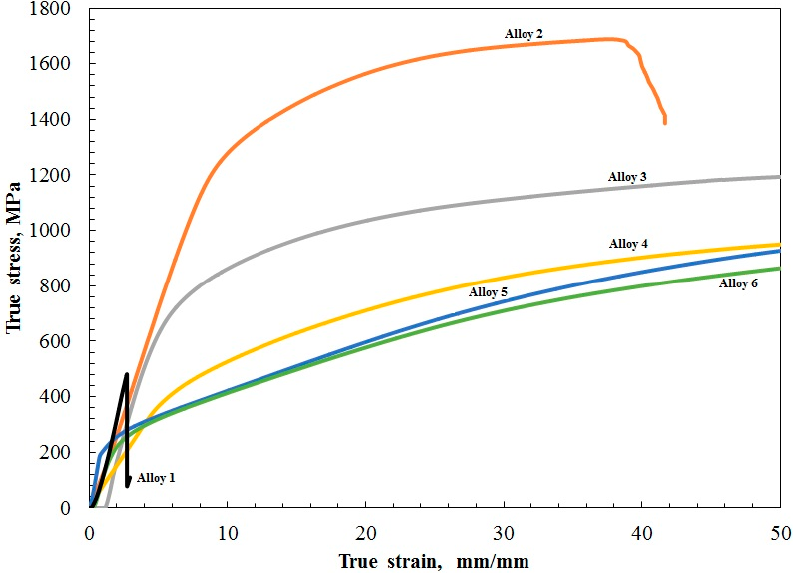
Figure 11. Typical true stress–strain curves of compression for the as-cast six Fe–Mn–Ni–Cr–Al–Si HEAs.